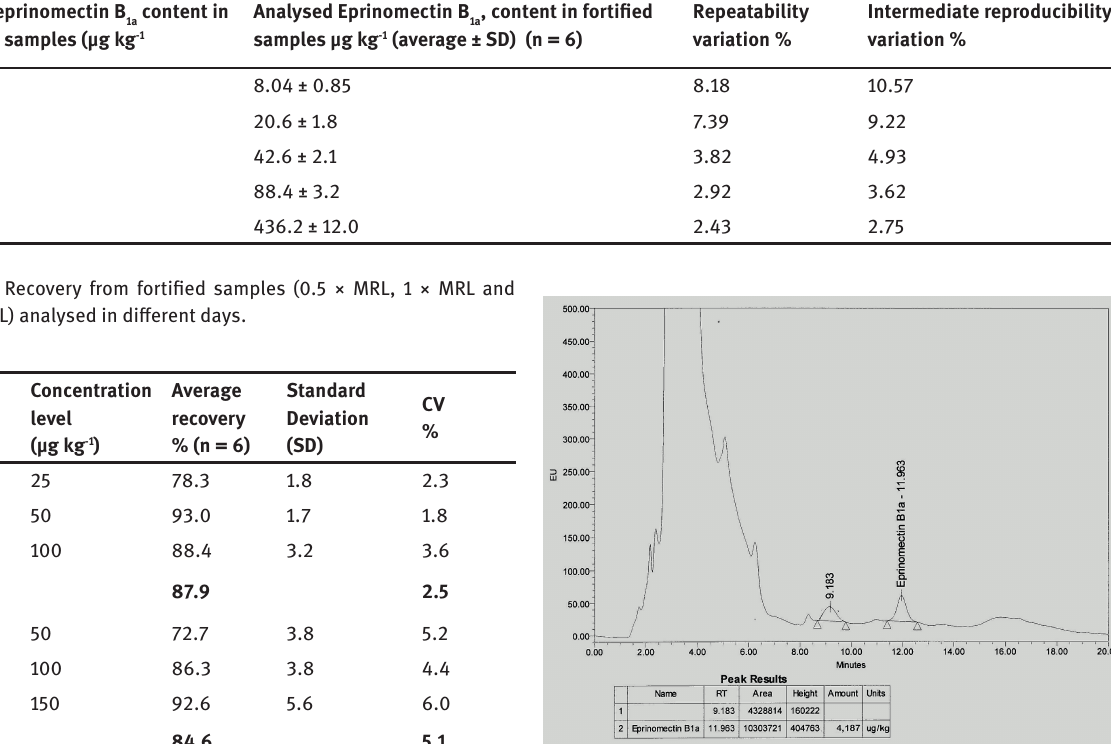
Figure 3: HPLC-FLD chromatogram of fortified muscle with 5 µg kg -1 eprinomectin B 1a